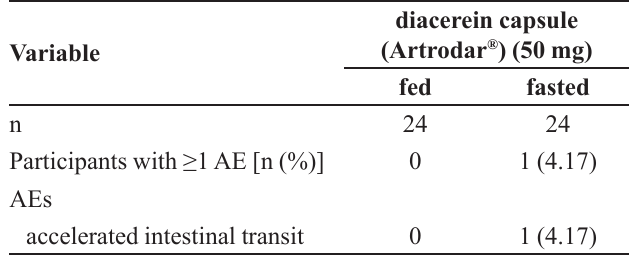
TABLE III - Incidence of adverse events